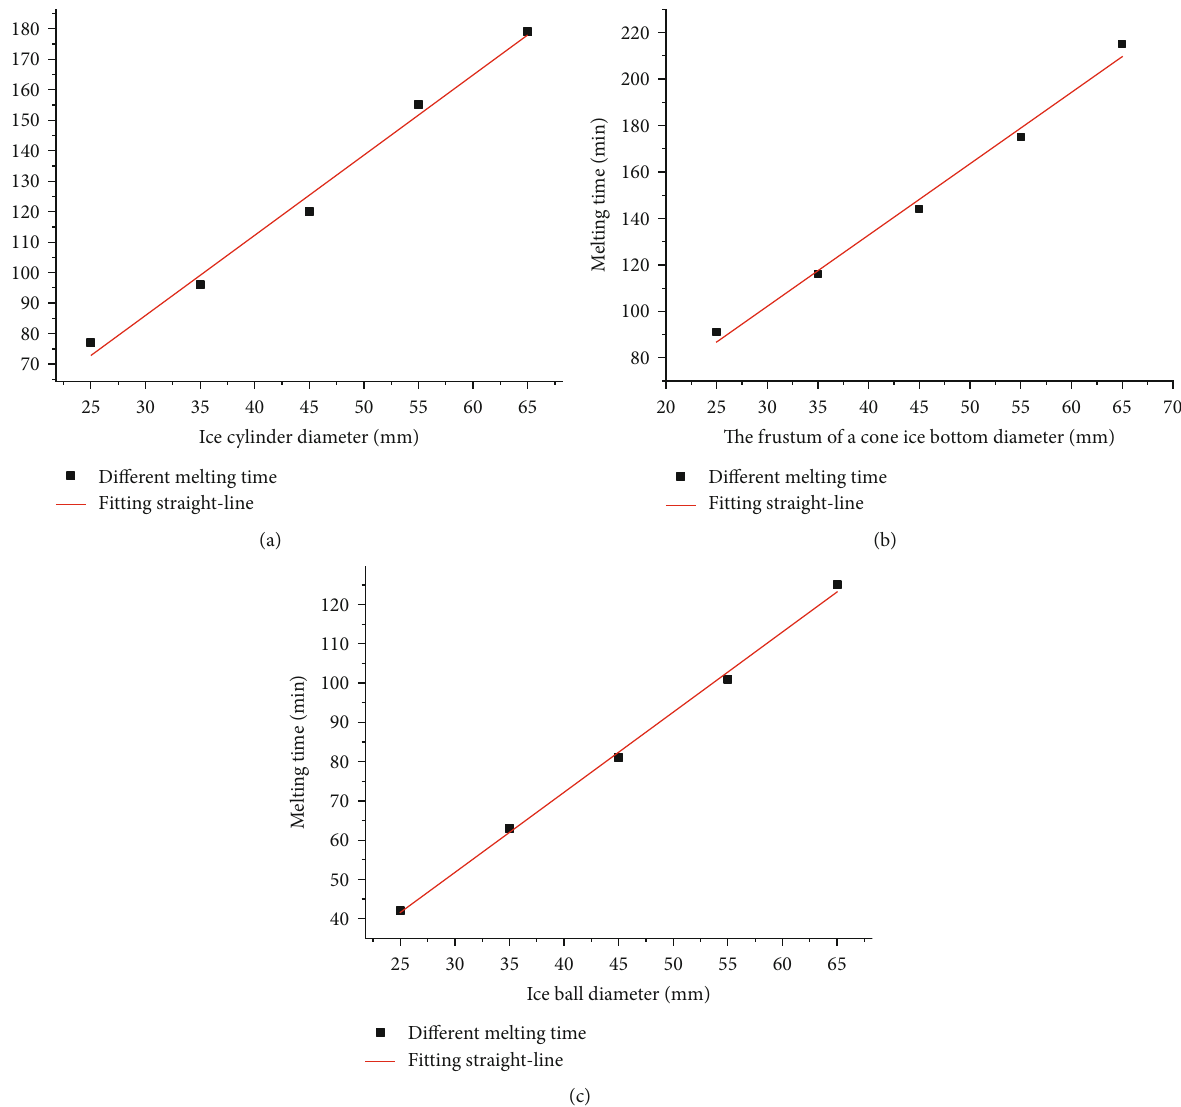
Figure 1: The linear fi t between the melting time and diameter: (a) ice cylinder, (b) ice circular truncated cone, and (c) ice